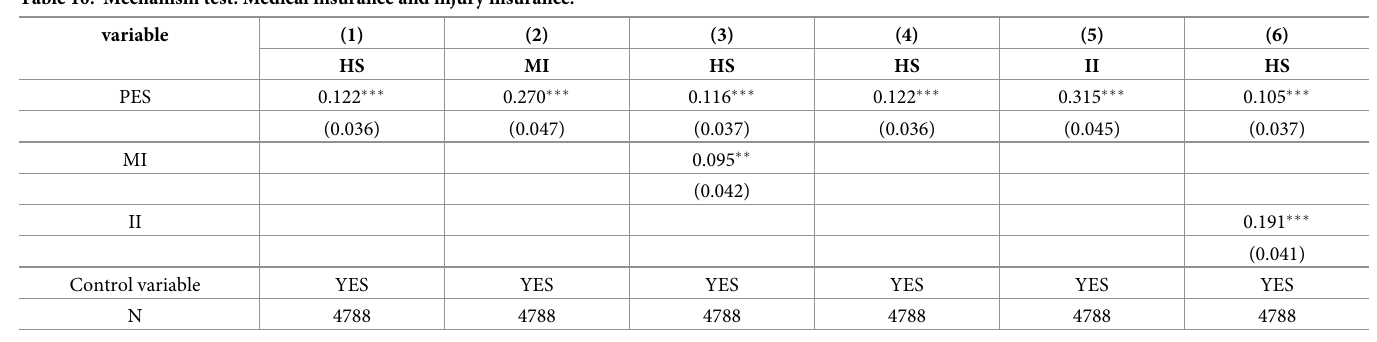
Table 10. Mechanism test: Medical insurance and injury